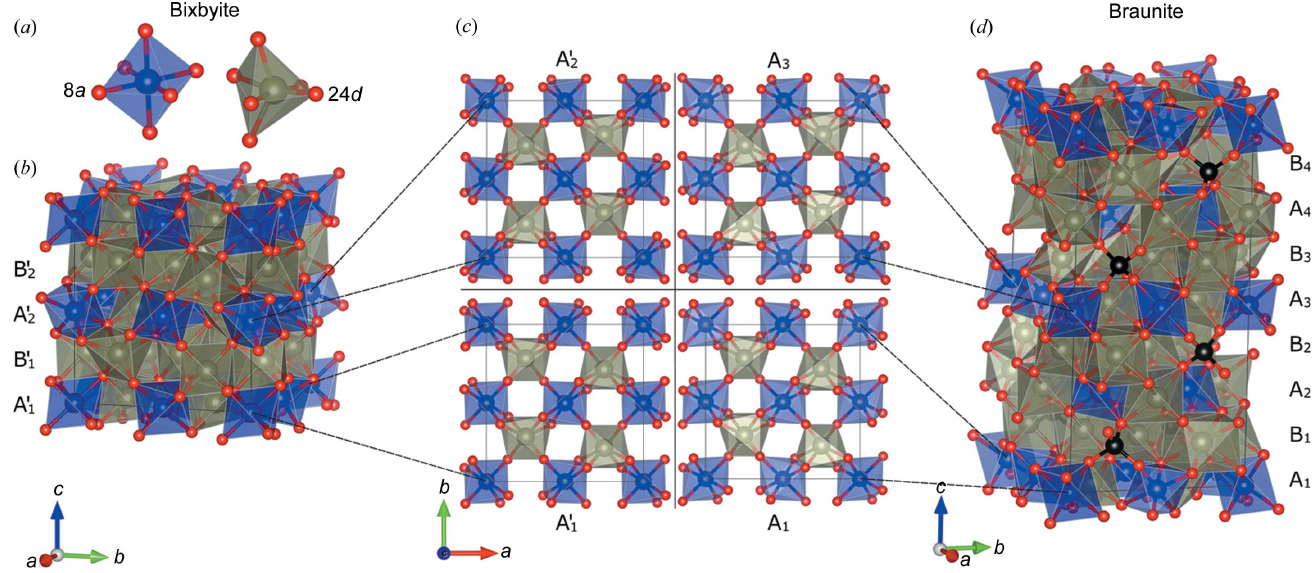
Figure 2 Crystal structures of ( b ) bixbyite and ( d ) braunite with the cation layers labelled as described in the text. In ( a ) the 8 a site of bixbyite is coloured blue, while the 24 d site is coloured grey. In ( c ) the corresponding sites in the braunite structure have been coloured equivalently to ease comparison of the (i) A 0 and A 1 layers, and (ii) A 0 and A 3 layers. The presence of silicon in the braunite B i is indicated by black spheres in ( d 2 1